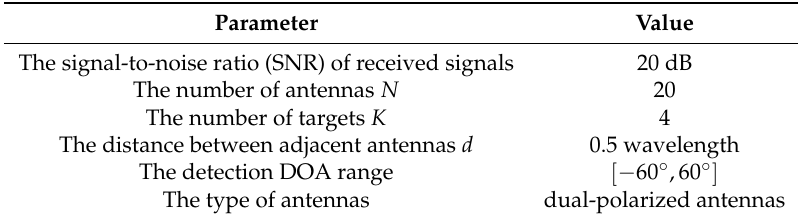
Table 1. Simulation